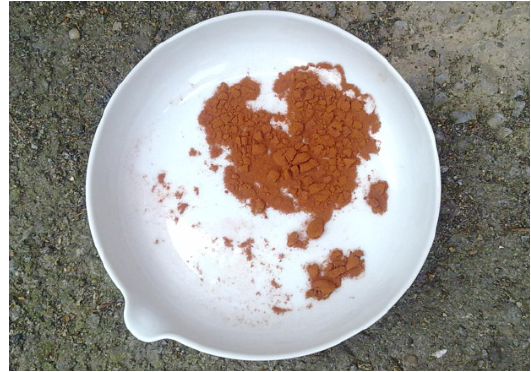
Figure 9. The obtained powder based on rare earth oxide.